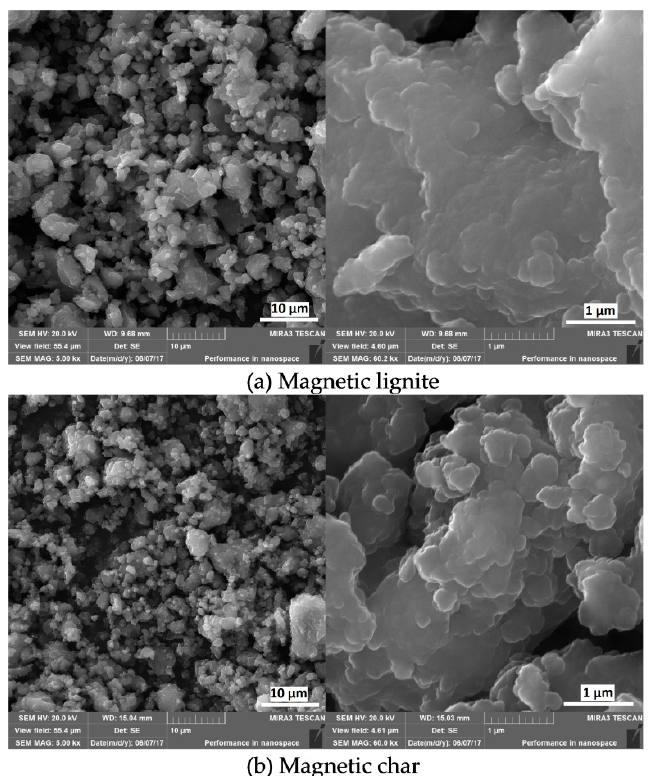
Figure 1. Field-emission scanning electron micrographs of the ( a ) magnetic lignite and ( b ) magnetic char.